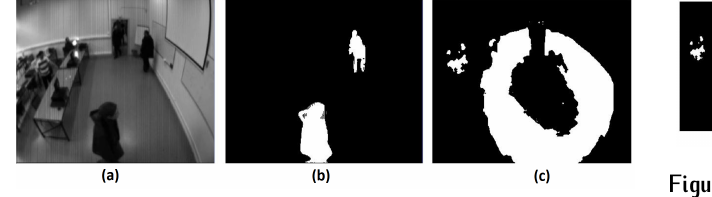
Figure 7. (a). Input Video (b). Frame difference (c). Frame